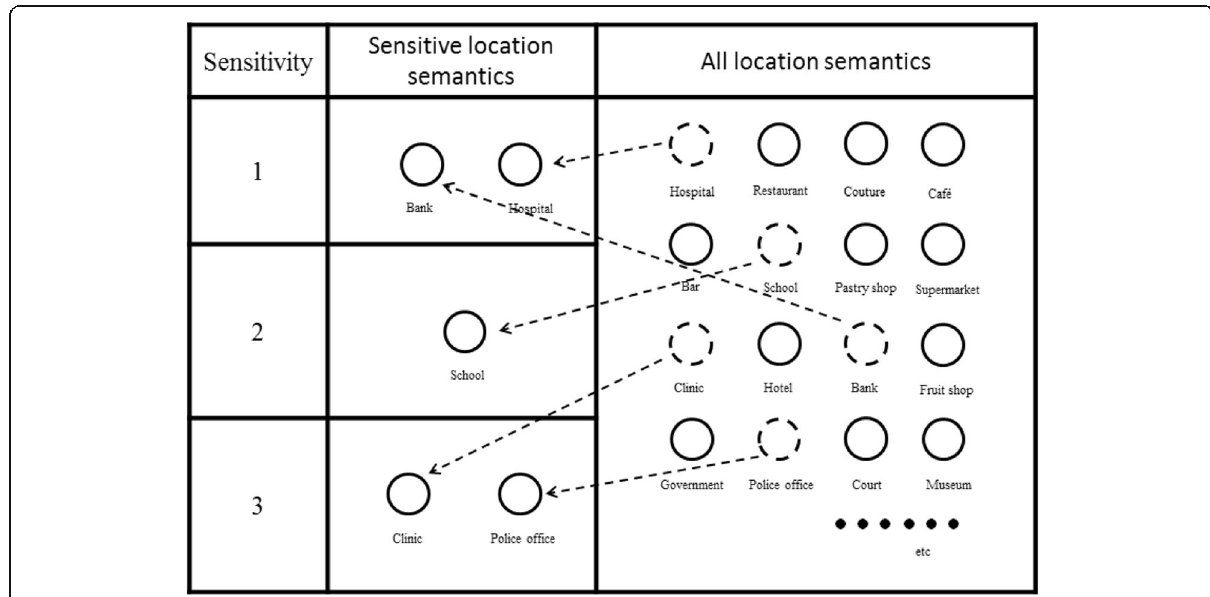
Fig. 2 Shows an example of sensitive location semantic selection. The sensitivity columns 1 to 3 indicate the degree of sensitivity, and the user needs to drag the user-sensitive location semantics from all location semantics columns to the sensitive location semantics